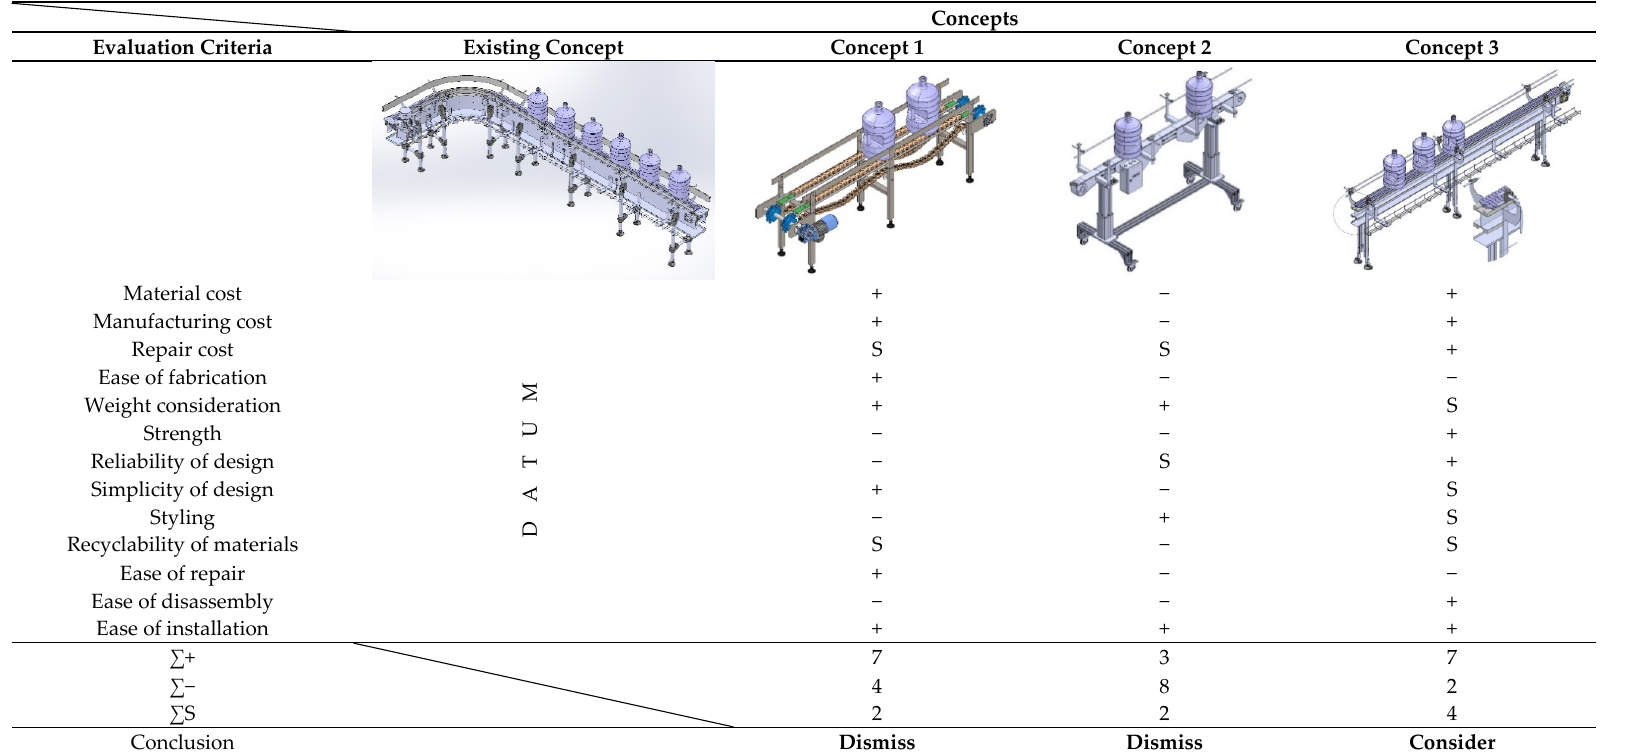
Table 4. Pugh Control Convergence method (PuCC) decision matrix.